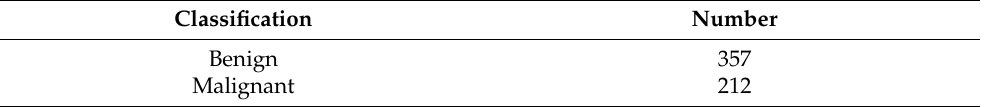
Table 1. Dataset of breast cancer